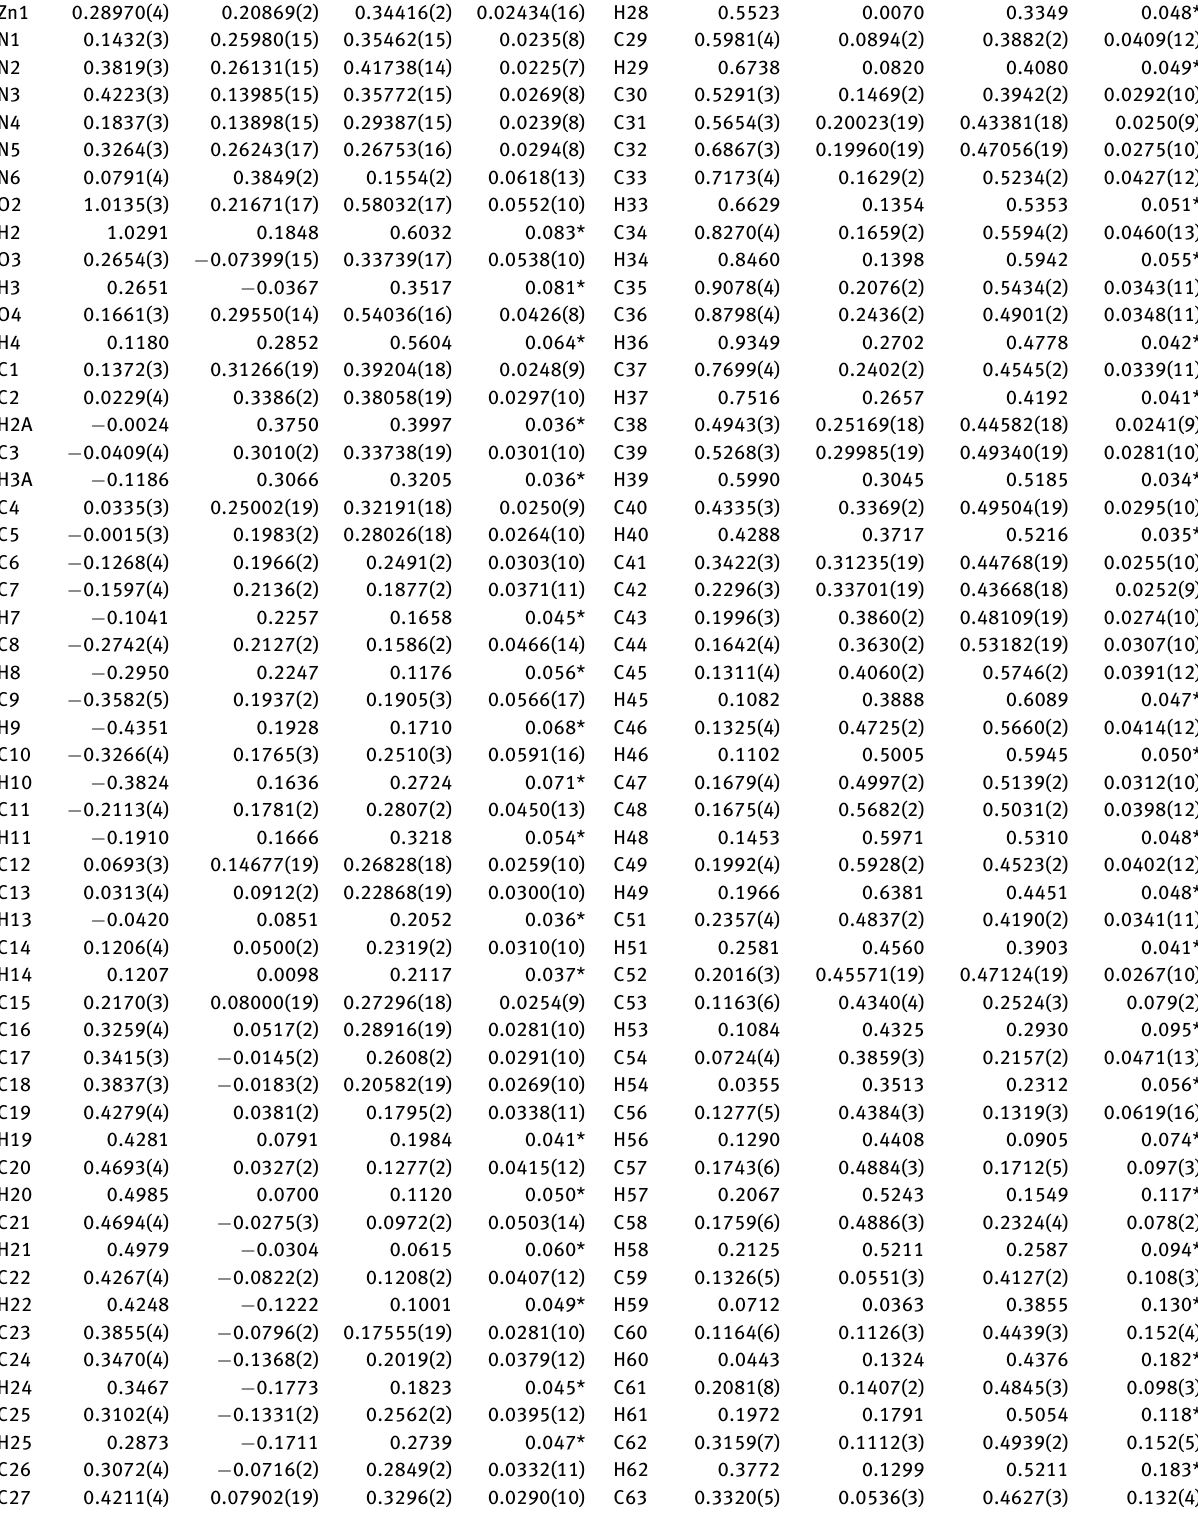
Table 2: Fractional atomic coordinates and isotropic or equivalent isotropic displacement parameters (Å 2